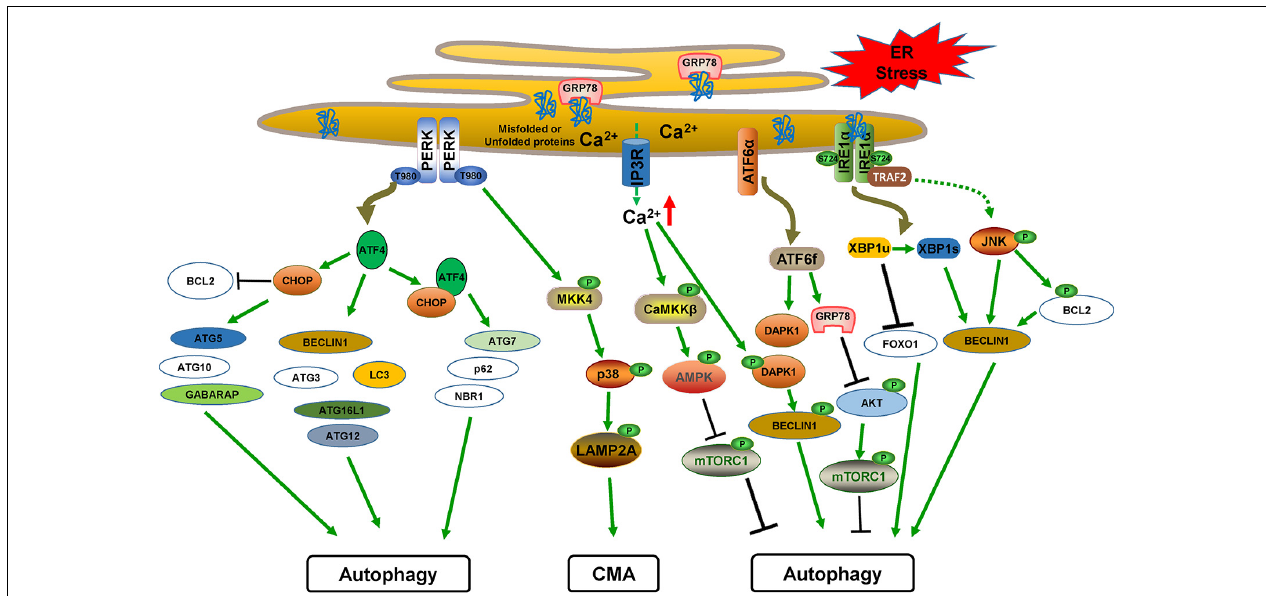
FIGURE 3 | The cross-links between ER stress/UPR and autophagy. PERK-mediated ATF4 translation induces CHOP. The transcriptional factors ATF4 and CHOP induce multiple ATG genes and autophagy regulatory factors alone or together. PERK also activates the MKK4/p38 pathway for CMA activation by phosphorylating LAMP2A. ATF6f activates the expression of GRP78, which inhibits AKT/mTORC1 activation, and DAPK1, which phosphorylates BECLIN1 to induce autophagy. IRE1 α activation leads to JNK signaling, which induces BECLIN1 expression and also phosphorylates BCL2 to dissociate BECLIN1 for autophagy activation. XBP1s generation by IRE1 α activation also transcriptionally activates BECLIN1